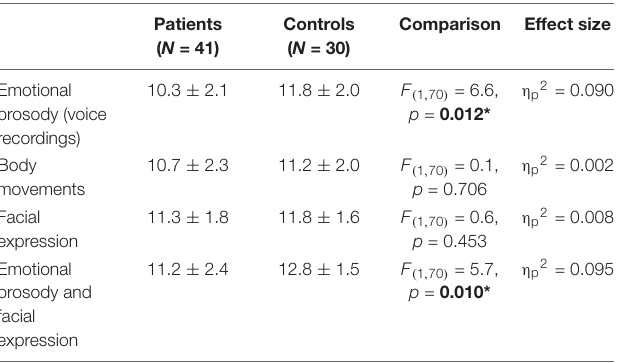
TABLE 2 | Comparison of the four PONS subscales between patients and controls, whilst controlling for education and working